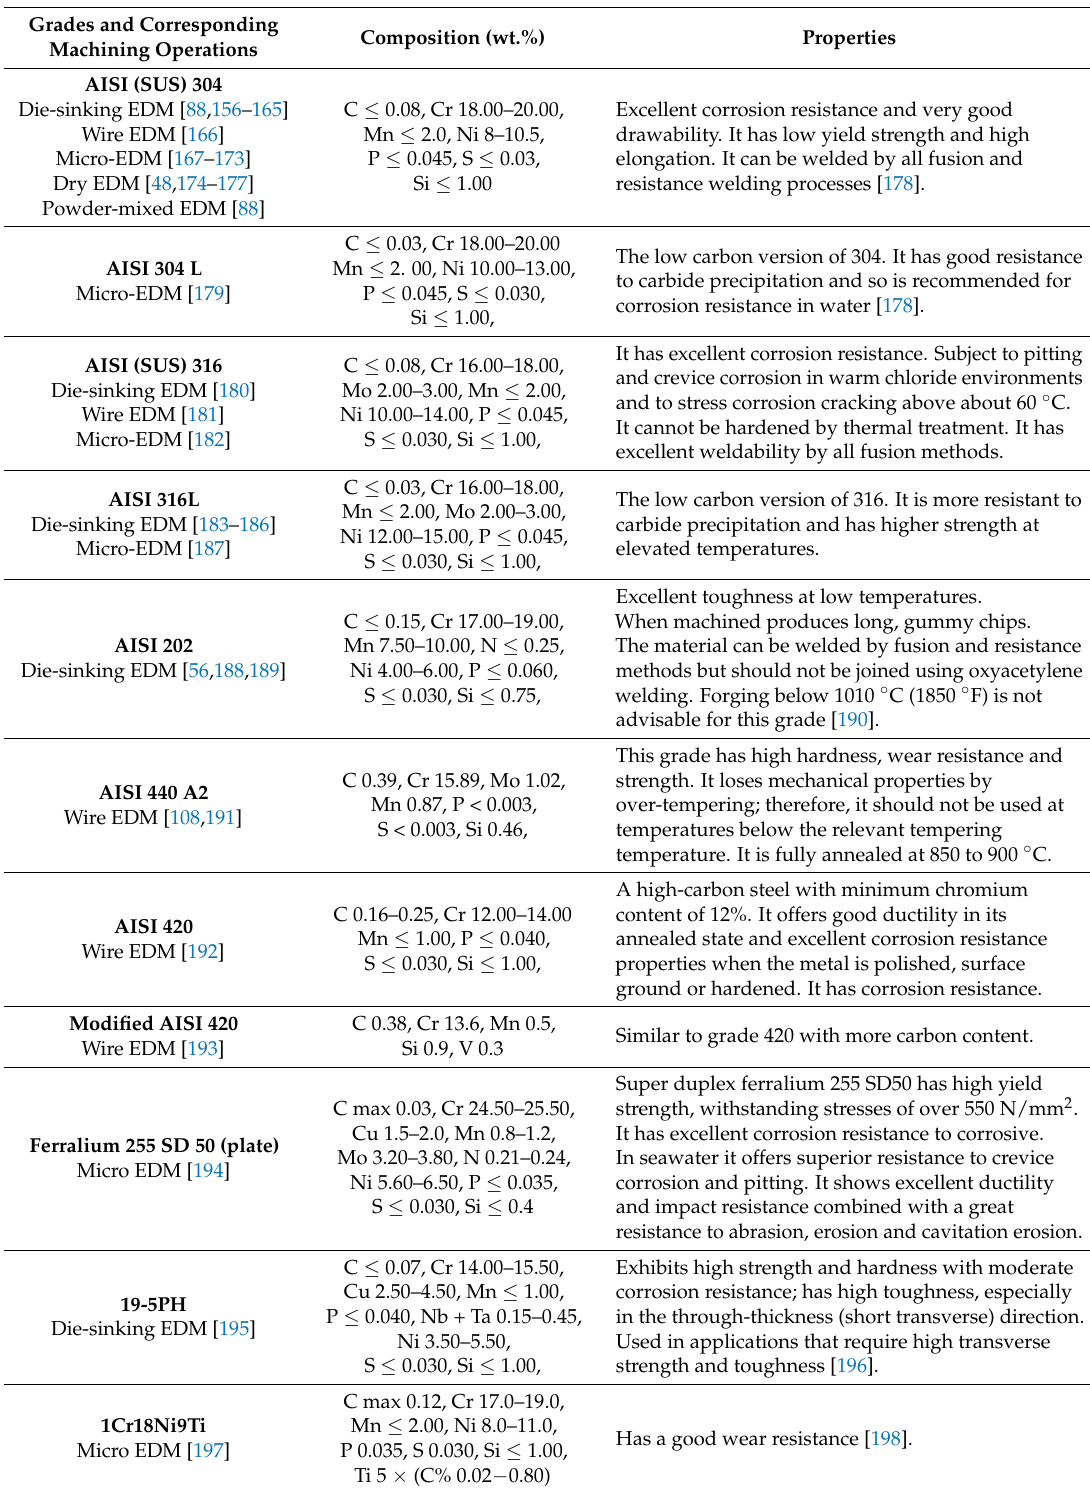
Table 2. Details of EDM process research studies for different grades of stainless